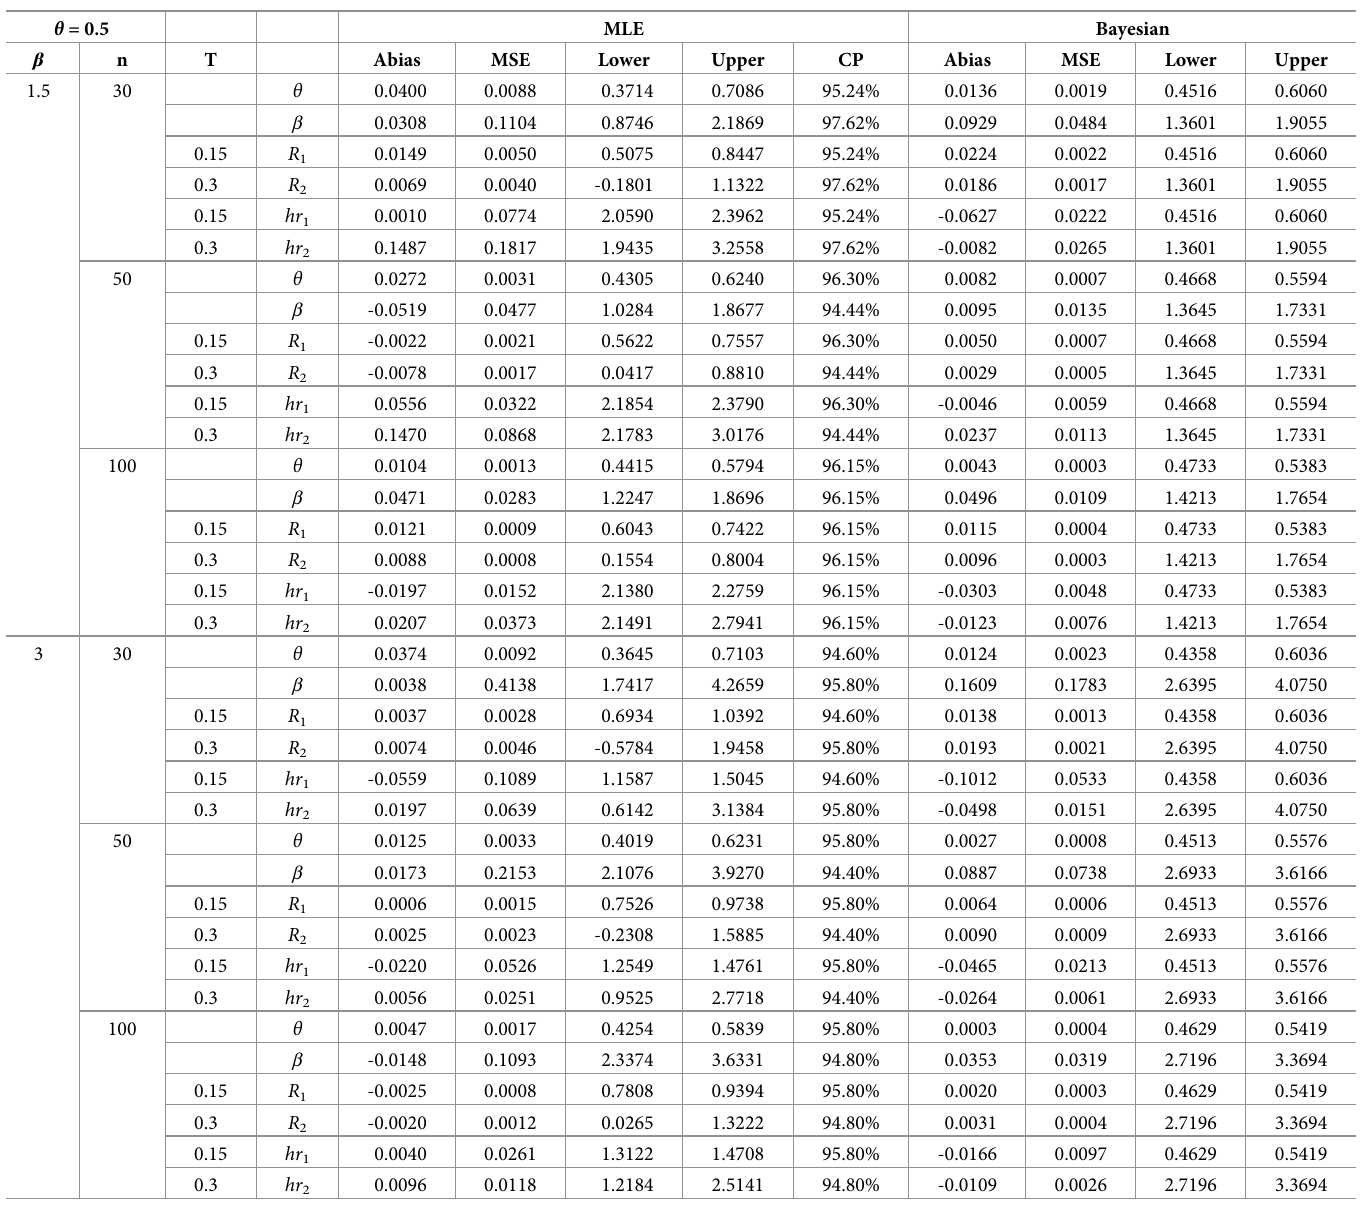
Table 3. Simulation results when the value of θ = 0.5. θ =